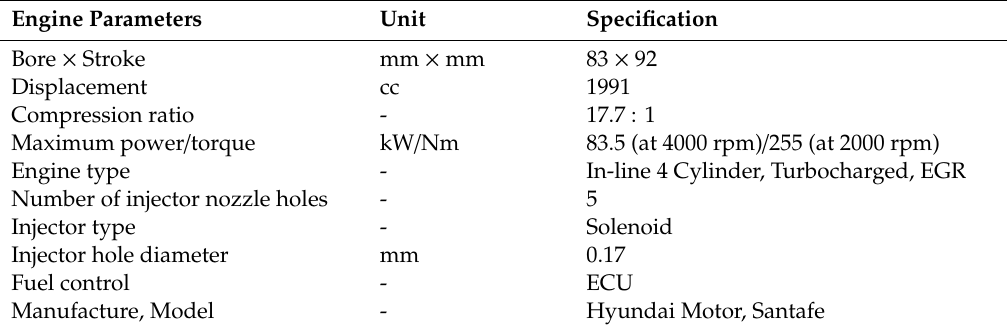
Table 3. Specifications of the test engine.